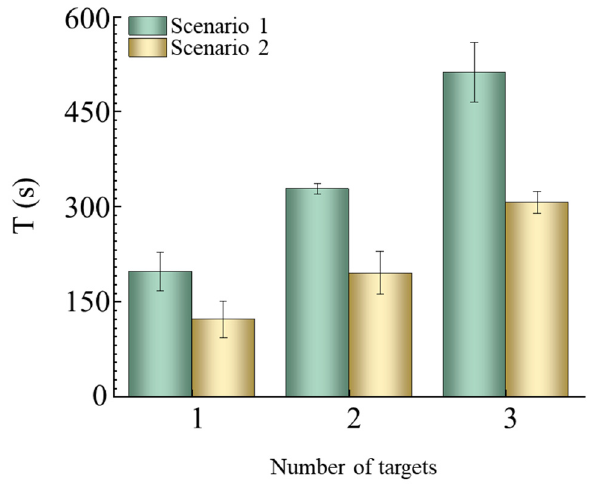
Figure 8. Mean and standard deviation of Table 2. The settings of the scenarios presented in this figure are the same as those in Figure 7.